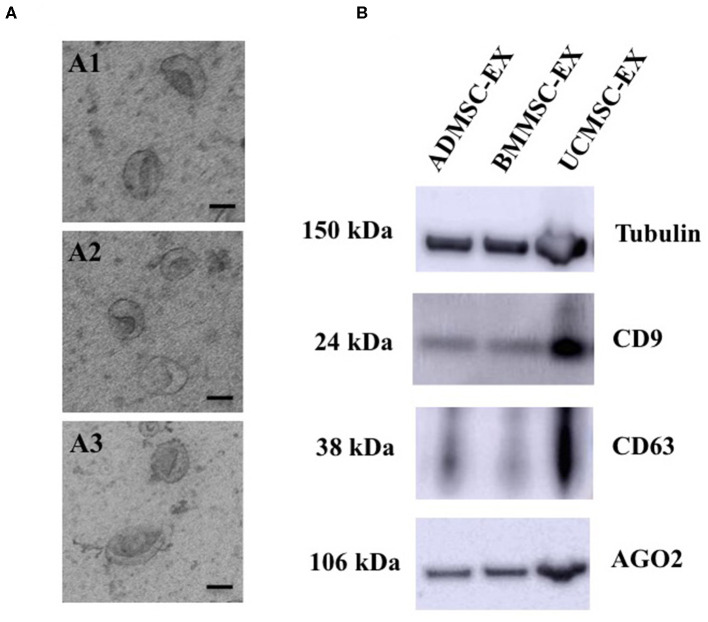
Morphology and marker analysis of exosomes derived from human primary ADMSCs, BMMSCs, and UCMSCs. (A) Morphology analysis of exosomes observed under TEM showed all exosomes have a cup-shape morphology (Scale bar: 100 nm): (A1) A representative of ADMSC-derived exosomes, (A2) A representative of BMMSC-derived exosomes, (A3) A representative of UCMSC-derived exosomes. (B) Exosomal proteins, 10 μg total protein were loaded each lane, including CD9, CD63, AGO2 and Tubulin, enriched in exosomes released from ADMSCs, BMMSCs, and UCMSCs. ADMSC-EX, ADMSC-derived exosomes; UCMSC-EX, UCMSC-derived exosomes; BMMSC-EX, BMMSC-derived exosomes. Data are representative of at least three independent experiments. Scale bars indicate 100 nm.